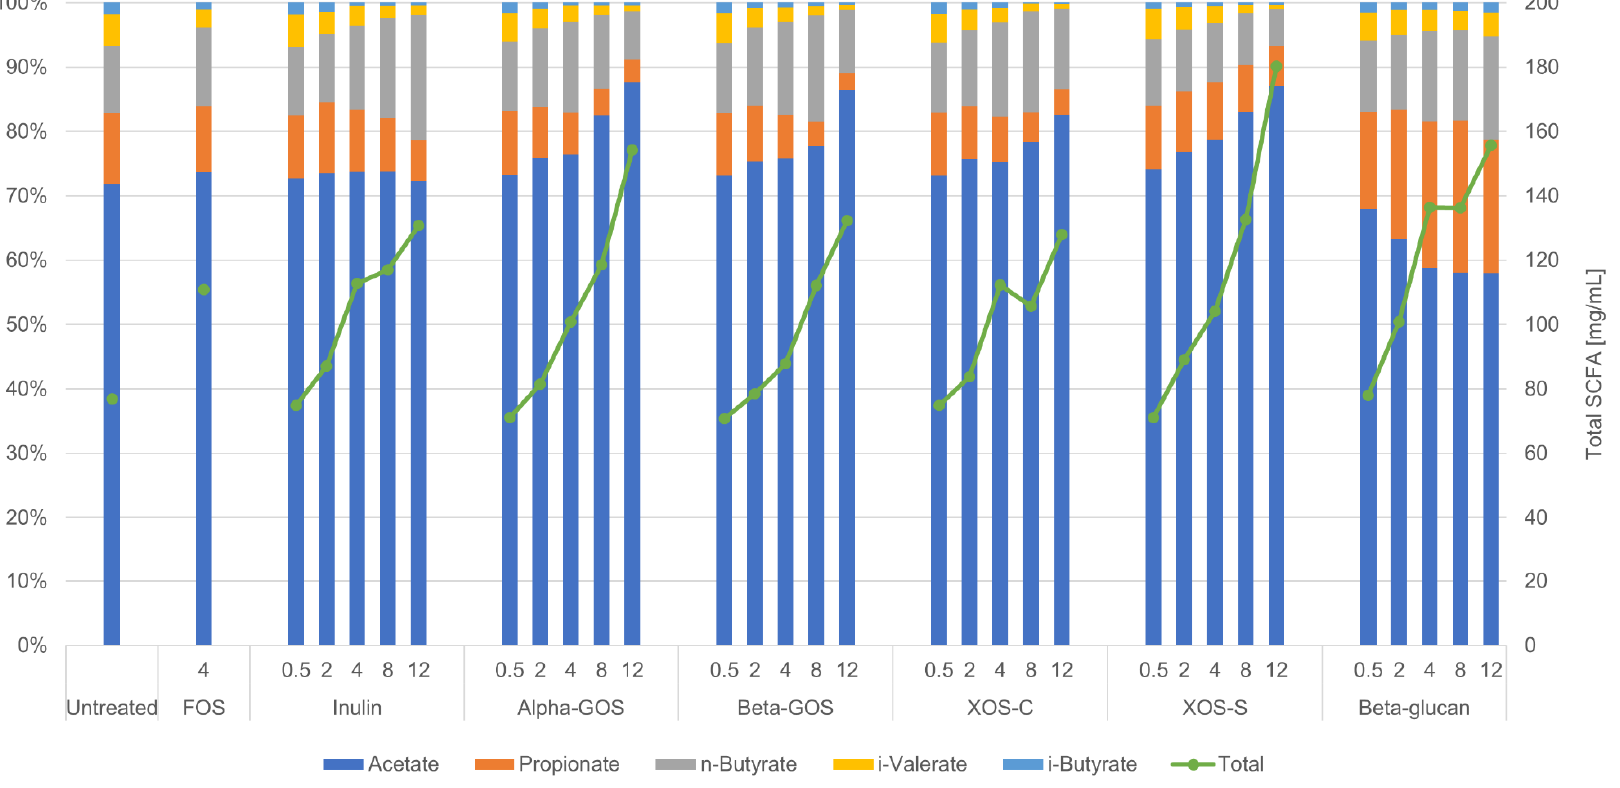
Figure 4. Total short-chain fatty acid (SCFA) concentrations and the relative percentages of SCFAs in the control and fiber-enriched samples. Acetate, propionate, butyrate, isovalerate, and isobutyrate were detected using gas chromatography (GC), and the total SCFA concentrations represent all metabolites measured.